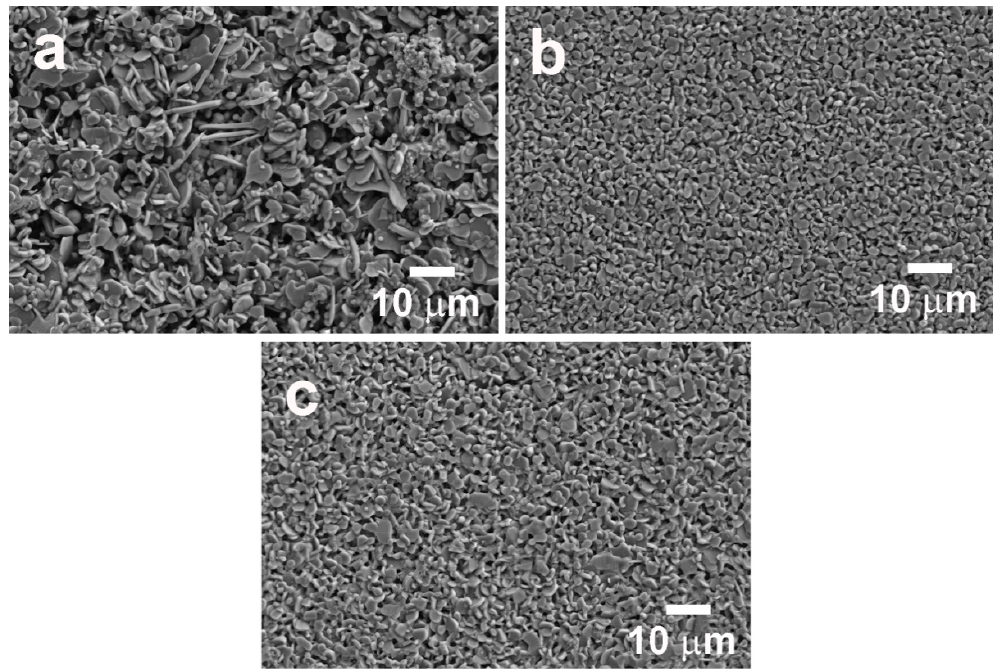
Figure 5. FESEM micrographs obtained on the surfaces of samples prepared from ( a ) ball-milled precursors; attrition-milled precursors sintered for ( b ) 4; ( c ) 16 h.